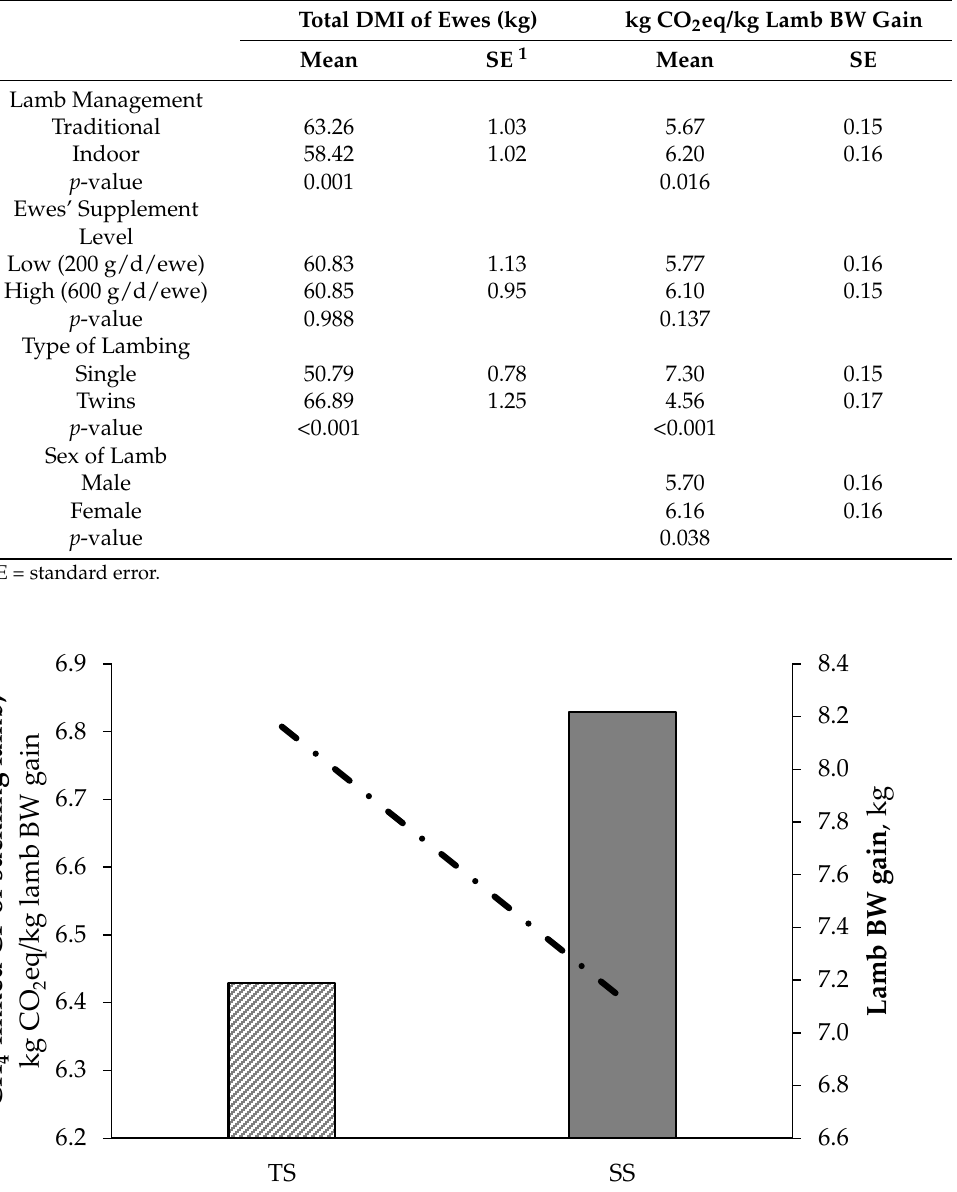
Figure 2. Methane-linked carbon footprint (CF) and lamb body weight (BW) gain in suckling lambs raised in the traditional (TS) and separated systems (SS).